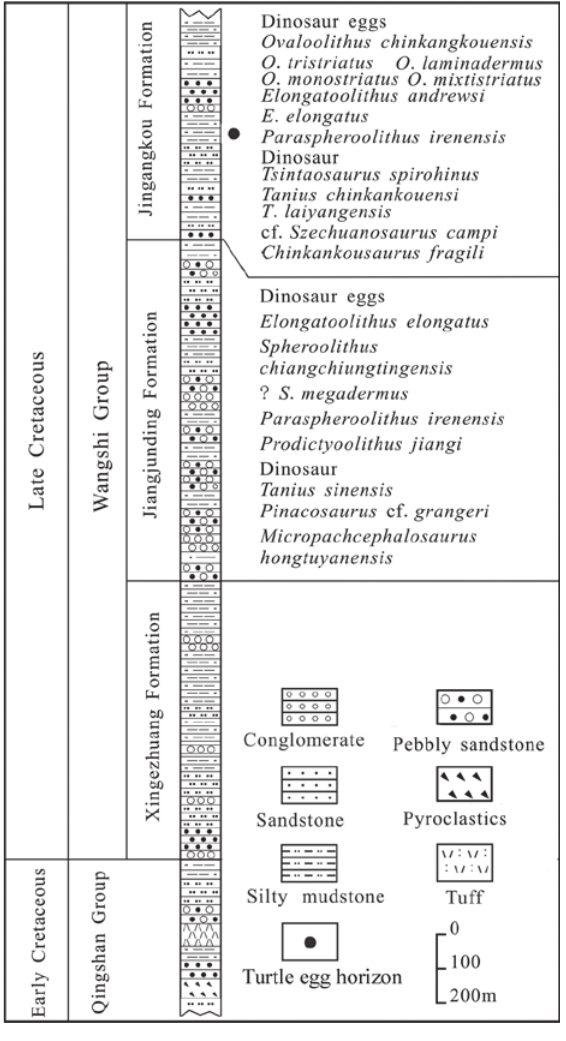
Fig. 2 - stratigraphy showing dinosaurs, dinosaur eggs and turtle egg of the Laiyang Basin, Shandong Province (Modified from Wang et al.